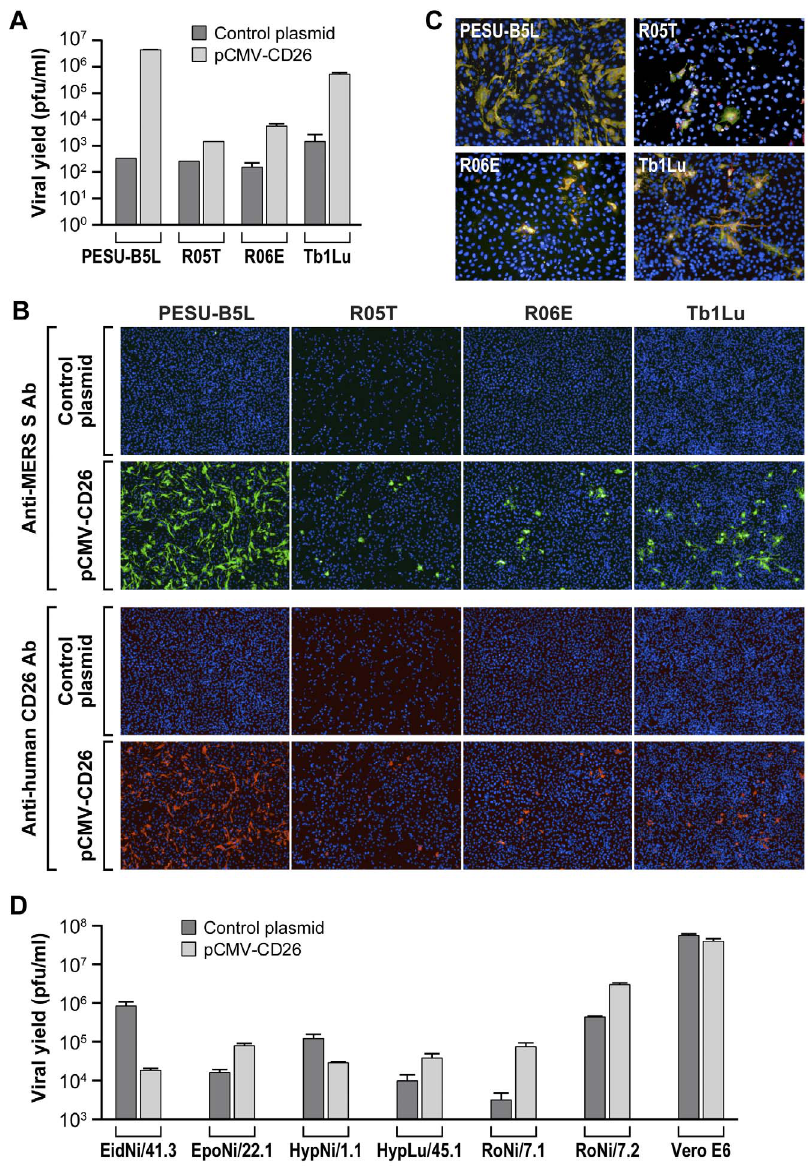
Figure 4. Expression of human CD26/DPP4 confers MERS-CoV susceptibility to otherwise resistant bat cells. (A) Viral yields from MERS- CoV-resistant PESU-B5L, R05T, R06E, and Tb1Lu bat cells. Cells were transfected with a plasmid expressing human CD26/DPP4 or empty control plasmid and exposed 48 h later to MERS-CoV/EMC at an MOI of 3. Supernatants were harvested at 24 h after virus exposure for quantification of virus yields by plaque assay. (B) Same experiment: representative immunofluorescence assay (IFA) images of cells stained with anti-MERS-CoV spike protein antibody (green, top) or anti-human CD26/DPP4 antibody (red, bottom). (C) Merged IFA images demonstrate colocalization of MERS-CoV spike protein and CD26/DPP4. (D). Viral yields from MERS-CoV-susceptible bat cells transfected with a plasmid expressing human CD26/DPP4 or empty control plasmid using procedures identical to resistant cells in (A) except that cells were exposed to virus 24 h after transfection. Error bars indicate the standard deviation of duplicate